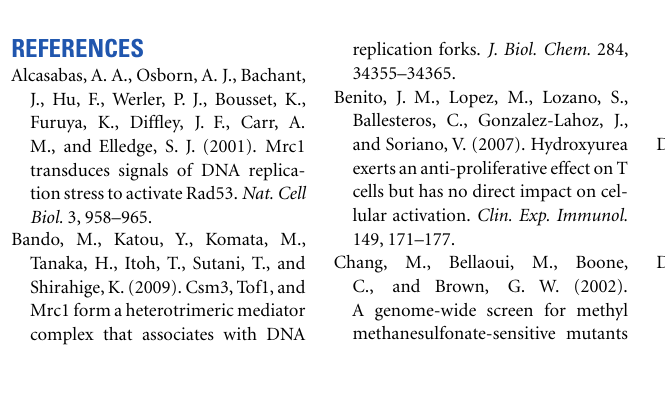
FIGURE 4 | Role of HU and ISC1 deletion on the survival of mice and on lung tissue burden. (A) Survival curve of CBA/J mice upon infection withWT Cn in the presence (green) or absence (black) of HU; (B) Survival curve of CBA/J mice upon infection with Cn isc1 (cid:2) cells